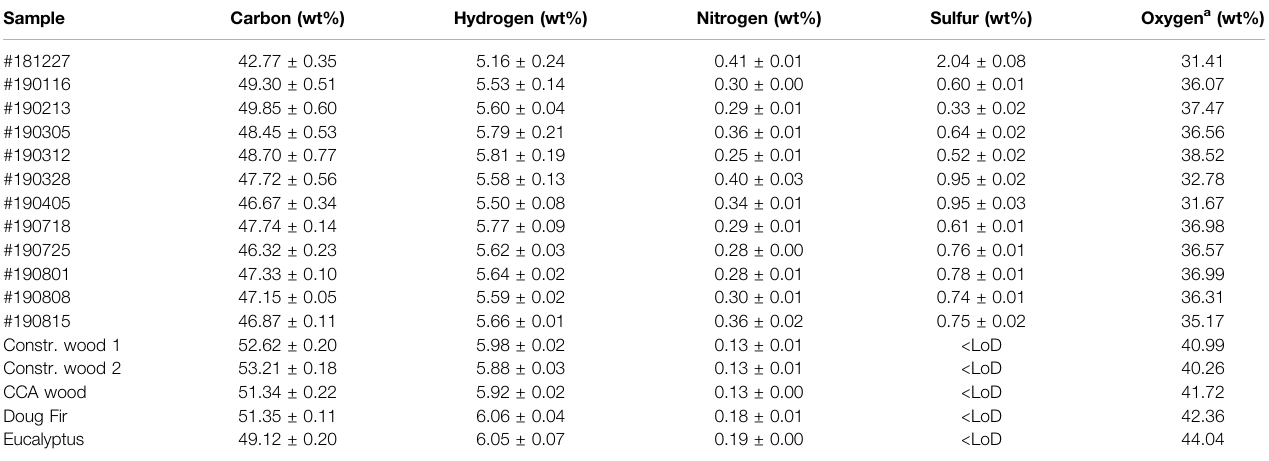
TABLE 4 | Ultimate analysis of CCDWDF materials and reference woods (on dry basis).